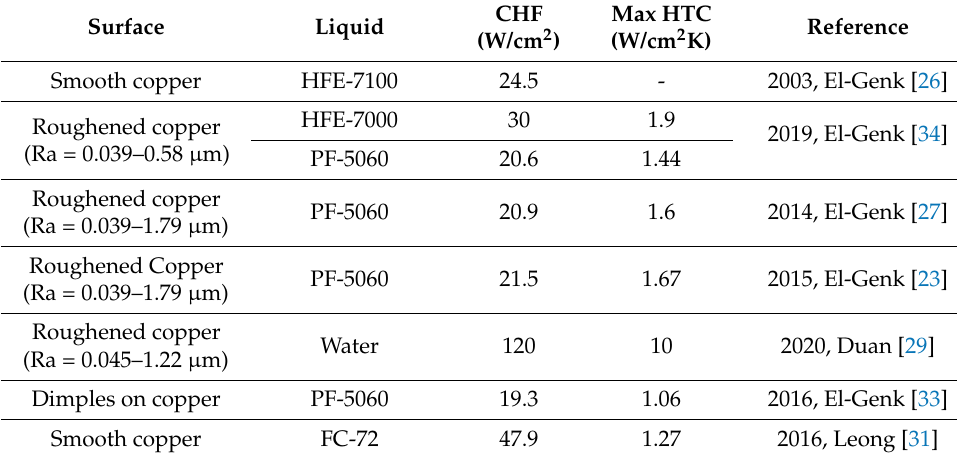
Table 2. Experiments of single-layer surface